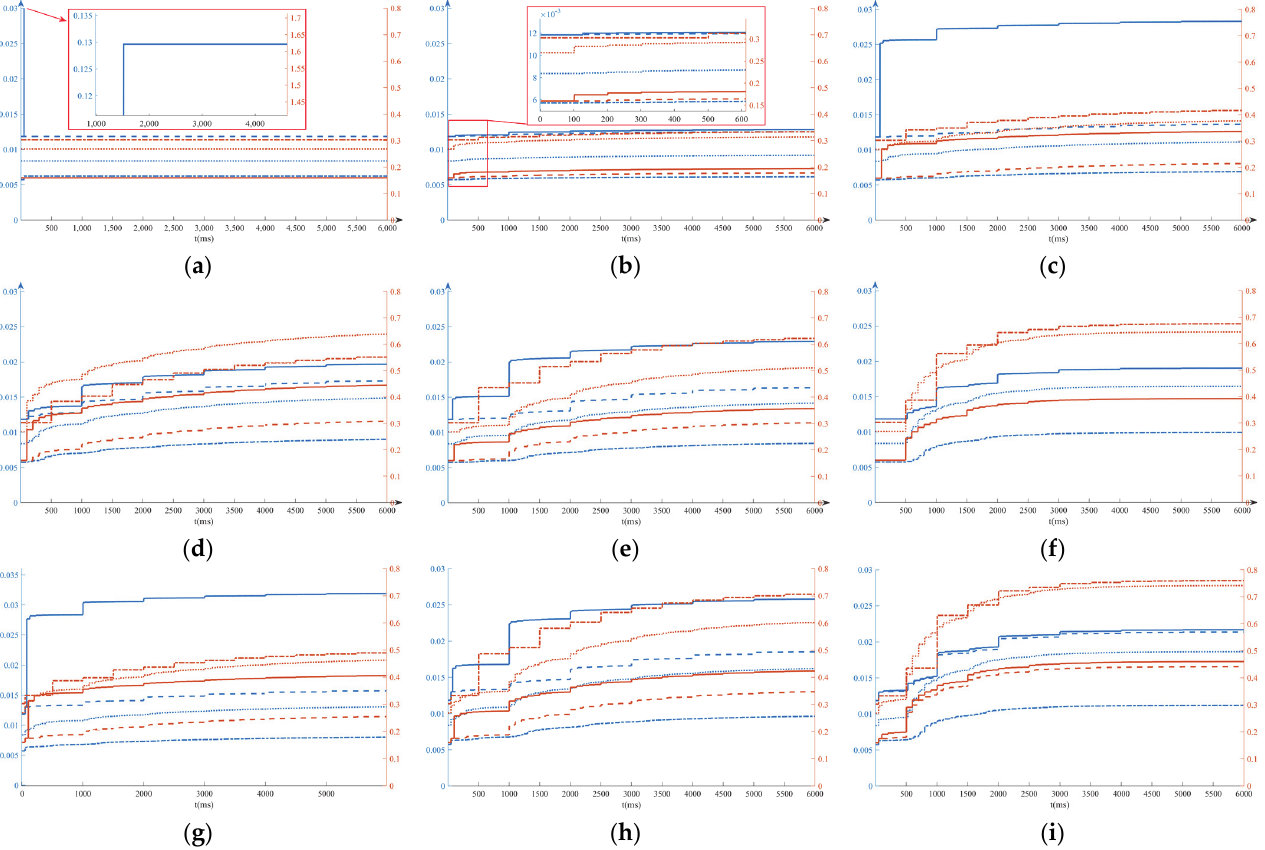
Figure 9. Dynamic diagram of failure probability of multi-type attack. ( a ) CB (bay A) is attacked, ( b ) transformer (bay A) is attacked, ( c ) CB-IED (bay A) is attacked, ( d ) MU (bay A) is attacked, ( e ) MD (bay A) is attacked, ( f ) NCCS is attacked, ( g ) transformer (bay A) and CB-IED (bay A) are attacked, ( h ) transformer (bay A) and MD (bay A) are attacked, ( i ) transformer (bay A) and NCCS are attacked.